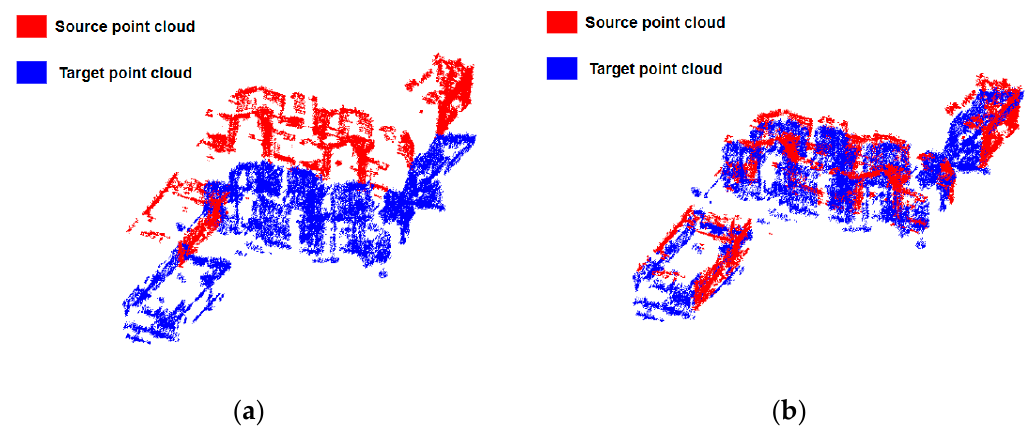
Figure 5. ( a ) The initial positions of the source and target point clouds. ( b ) The two point clouds after coarse alignment based on PCA.